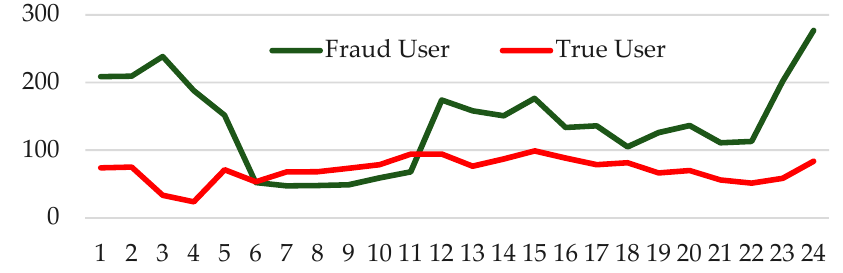
Figure 2. Fortnightly electricity power consumption pattern.